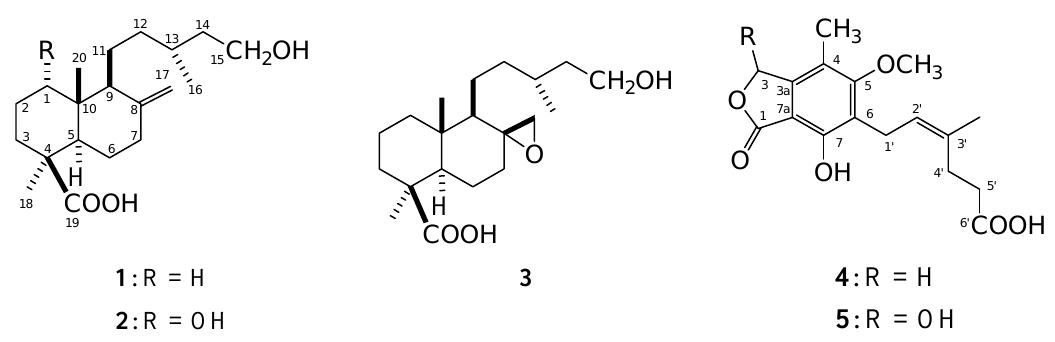
Figure 1 . Structures of compounds 1 - 5